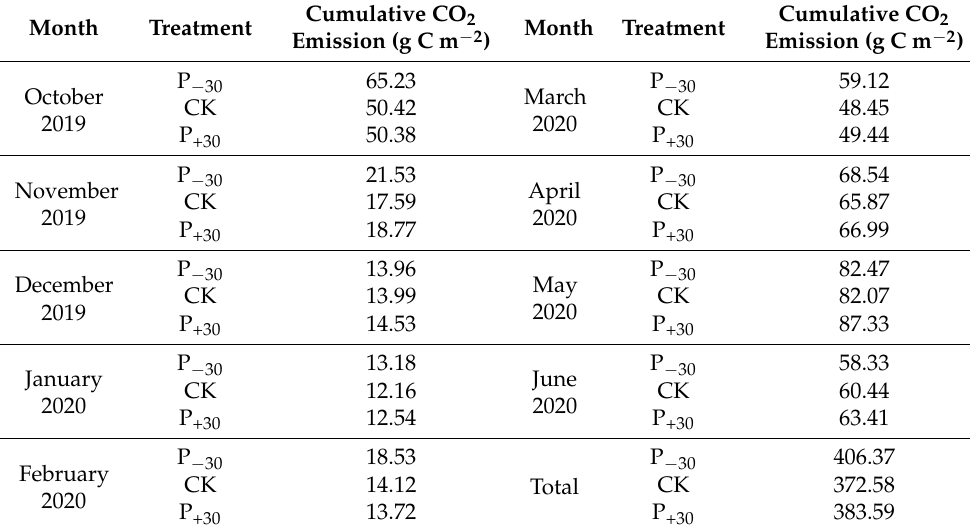
Table 1. Monthly and total cumulative CO 2 emissions in three precipitation treatments (P − 30 = 30% decreased precipitation, CK = natural precipitation, P +30 = 30% increased precipitation) during the winter wheat whole growth